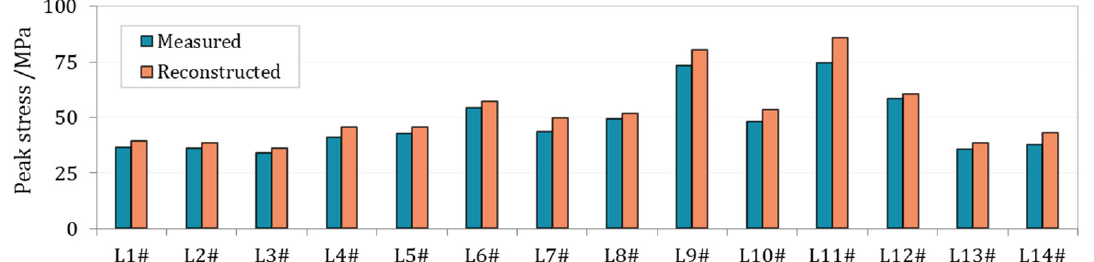
Figure 13. Bar plot of peak stress between measured and reconstructed values. NOTE: L1# represents the collective name of L1#SURF and L1#STRU, the same as in other points.